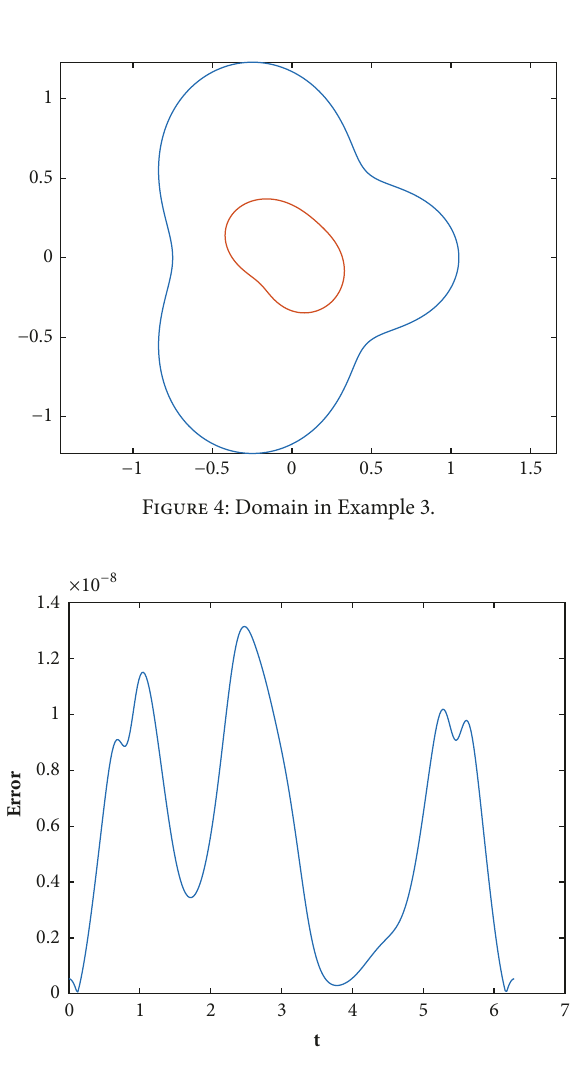
Figure 5: The absolute error along a circle with radius 0.6 in Example